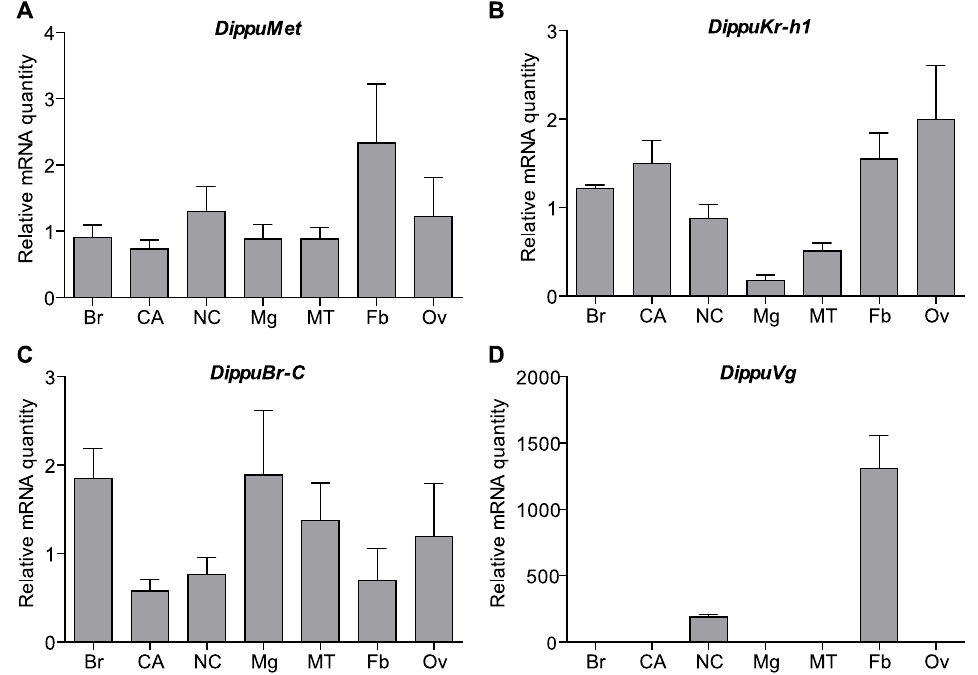
Figure 1. DippuMet , DippuKr-h1 , and DippuBr-C are broadly expressed across tissues of D.punctata . Relative mRNA quantity of DippuMet (A), DippuKr-h1 (B), DippuBr-C (C), and DippuVg (D) was measured in the tissues of mated female animals four days after imaginal moult. Grey bars represent the mean over three independent pools of ten animals and technical replicates, normalized to Tub and EF1 a . Vertical error bars indicate SEM. Brain (Br), corpora allata (CA), nerve cord (NC), midgut (Mg), Malpighian tubules (MT), fat body (Fb), and ovary (Ov).